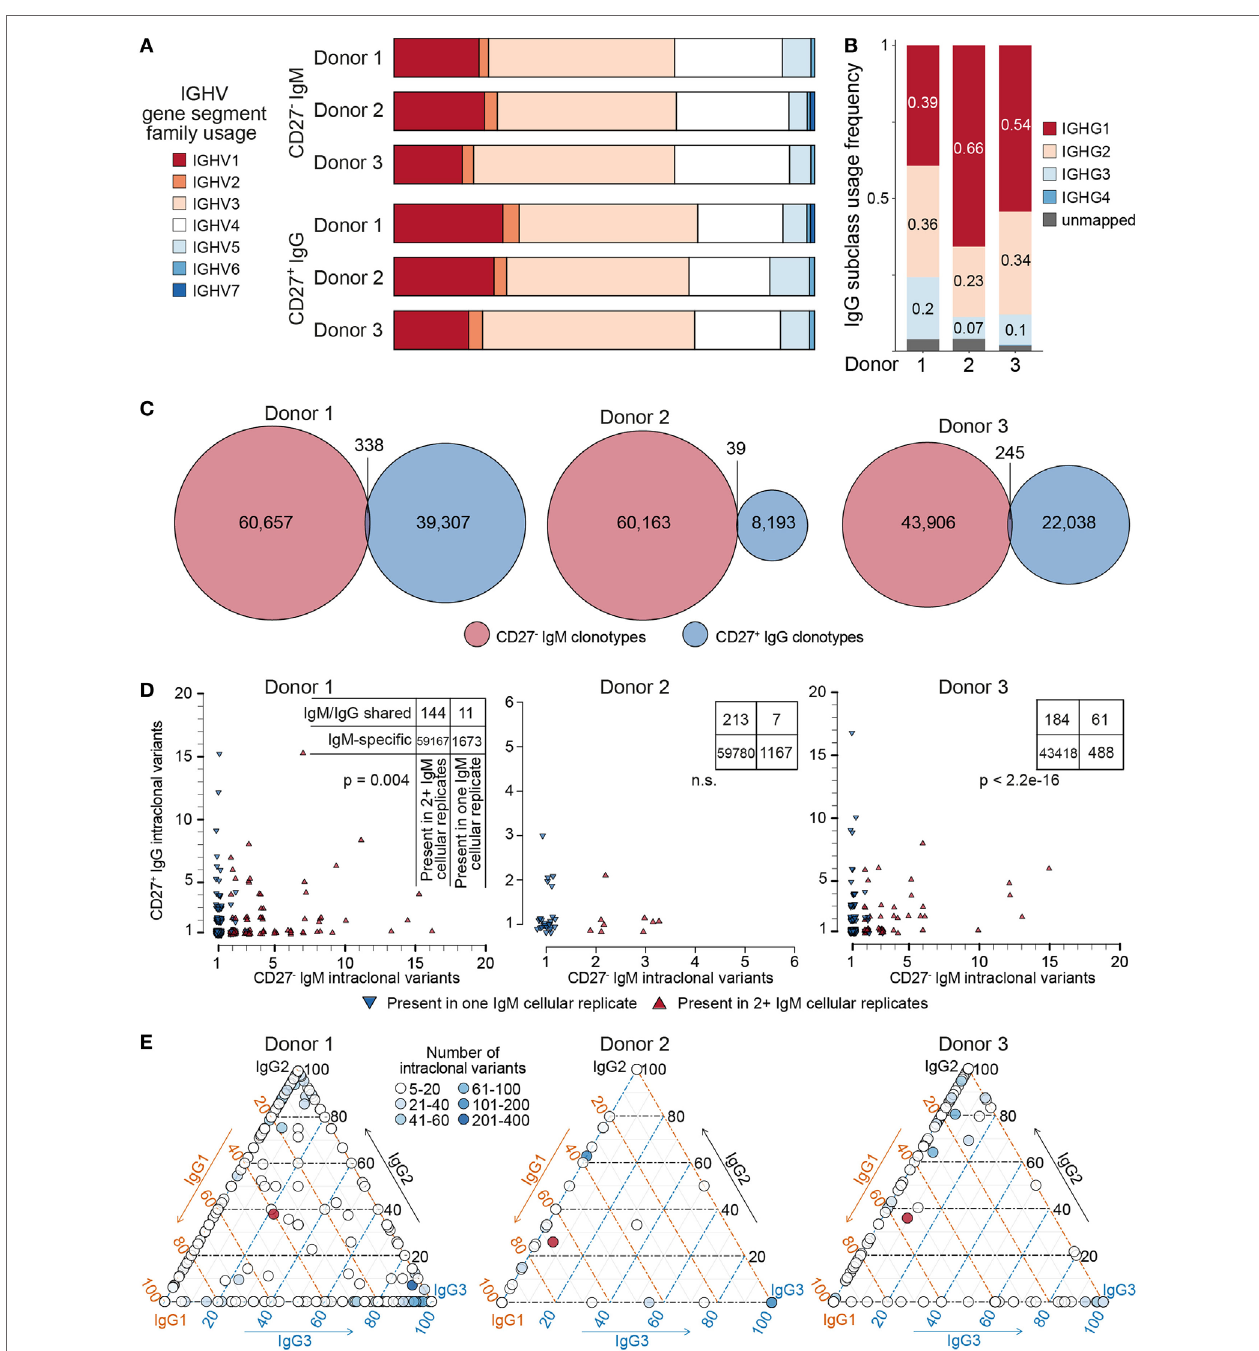
FIgURe 7 | Genetic features of naïve and IgG memory BCR repertoires. (A) Bar graph depicting IGHV-gene segment usage sorted by family (color-coded) across donors and B cell subset; bars are normalized to the total number of clonotypes within each group. (B) IgG subclass usage in CD27 + IgG + donor repertoires. IgG 4 sequences (dark blue bars) were virtually absent among three donors; a small fraction of sequences could not be unambiguously mapped based on the sequencing read (gray bars). (c) Venn diagrams showing the overlap of clonotypes (80% CDR-H3 amino acid similarity to least one clone in the cluster, same complementarity determining region 3 (CDR3) a.a. length, same IGHV and IGHJ gene segment usage) between the naïve (CD27 − IgM + ) and memory (CD27 + IgG + ) BCR heavy-chain repertoire in each of three donors. (D) Each plot shows the clonal composition of each shared clonotype [from panel (c) ] in terms of its IgG and IgM intraclonal variants. Red triangles indicate clonotypes found in multiple IgM cellular aliquots; blue triangles show clonotypes which could only be found in one IgM cellular aliquot. The total number of clonotypes found are depicted in the corresponding contingency table. Fisher’s exact test was used to quantitatively analyze enrichment of expanded IgM clonotypes in the shared IgM/IgG subset. (e) Ternary plots comprised of three axes representing the IgG1, IgG2, and IgG3 isotype subclasses. The relative subclass composition of intraclonal variants per IgG clonotype (each represented by a circle colored according to the number of variants belonging to that clonotype) is depicted by the position of the circle within the triagonal space. Red circles represent the average subclass composition for all IgG variants of each donor as shown in panel (B)